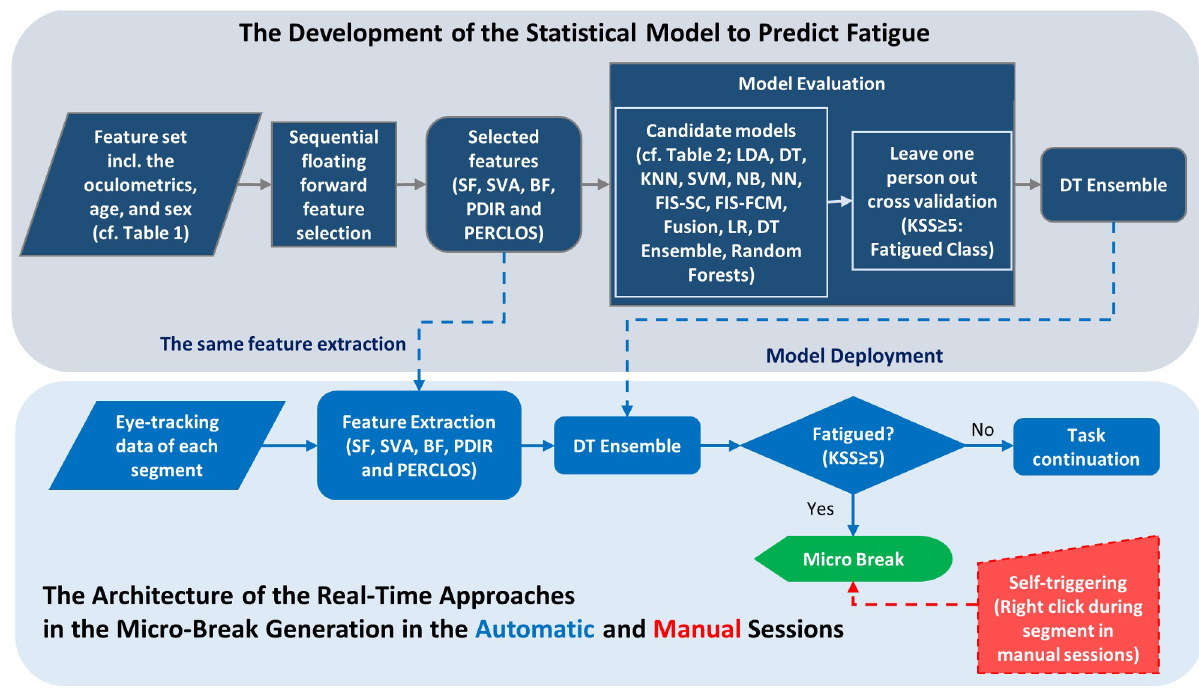
Fig 3. The architecture of the biofeedback system including the approaches to develop the statistical model to detect fatigue, and to trigger the micro-breaks. This architecture provides the flowchart of the main steps to develop the fatigue detection model, from the feature selection to the model evaluation and the deployment of the DT-Ensemble model in the biofeedback framework wherein the data were streaming from the eye tracker in real- time and the selected features were extracted in the end of each task segment and were fed into the deployed DT-Ensemble model to trigger the micro- break if fatigue was detected in the automatic sessions (light blue path), whereas the triggering of the micro-break was only based on the decision of the participant in the manual sessions (red